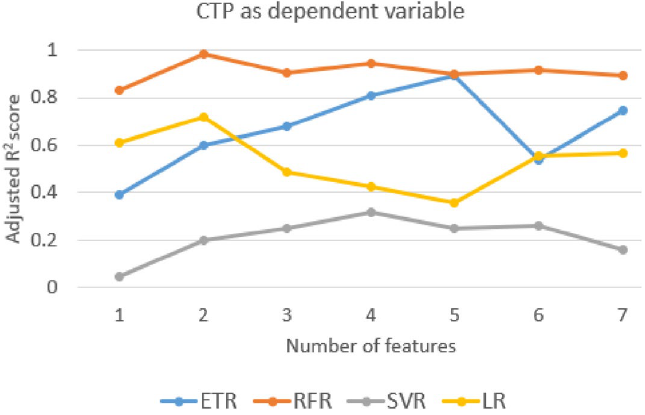
Figure 7. The adjusted R 2 value for different sets of features with CTP score as the dependent variable.